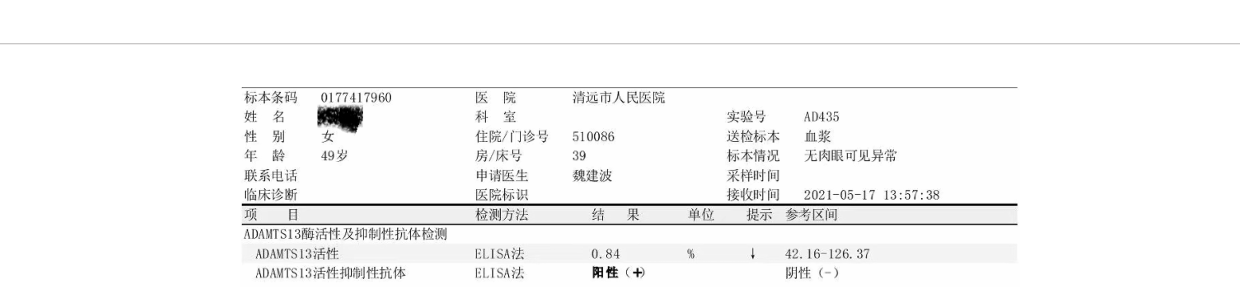
FIGURE 1 | Patient ’ s bone marrow smear. (Hyperplasia was active in bone marrow, no obvious compensatory hyperplasia and thrombocytopenia were observed in red system.)